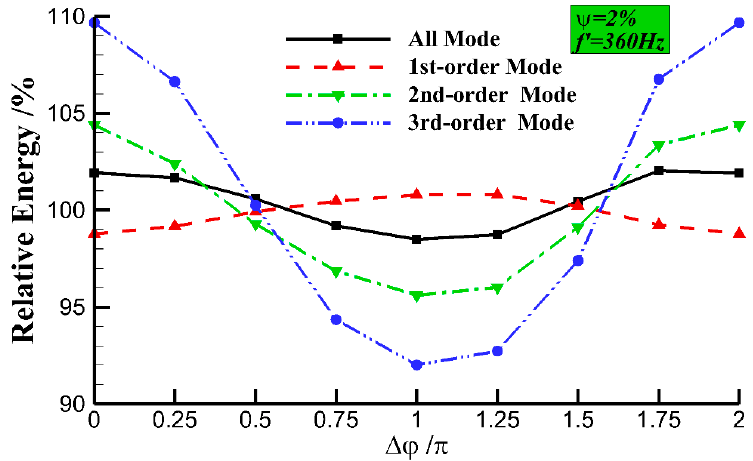
Figure 18. Modal energy under different control phases.